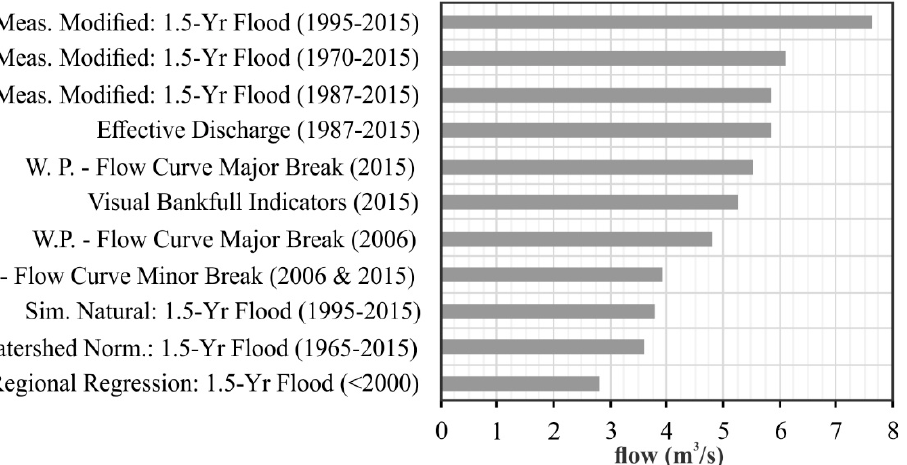
Figure 6. Comparison of bankfull flow estimates. Methods included annual peak in daily average flow data for 1.5-year flood flow estimates, visual field indicators, wetted perimeter–flow curve minor and major breakpoints, Wyoming regional regression, and effective discharge.